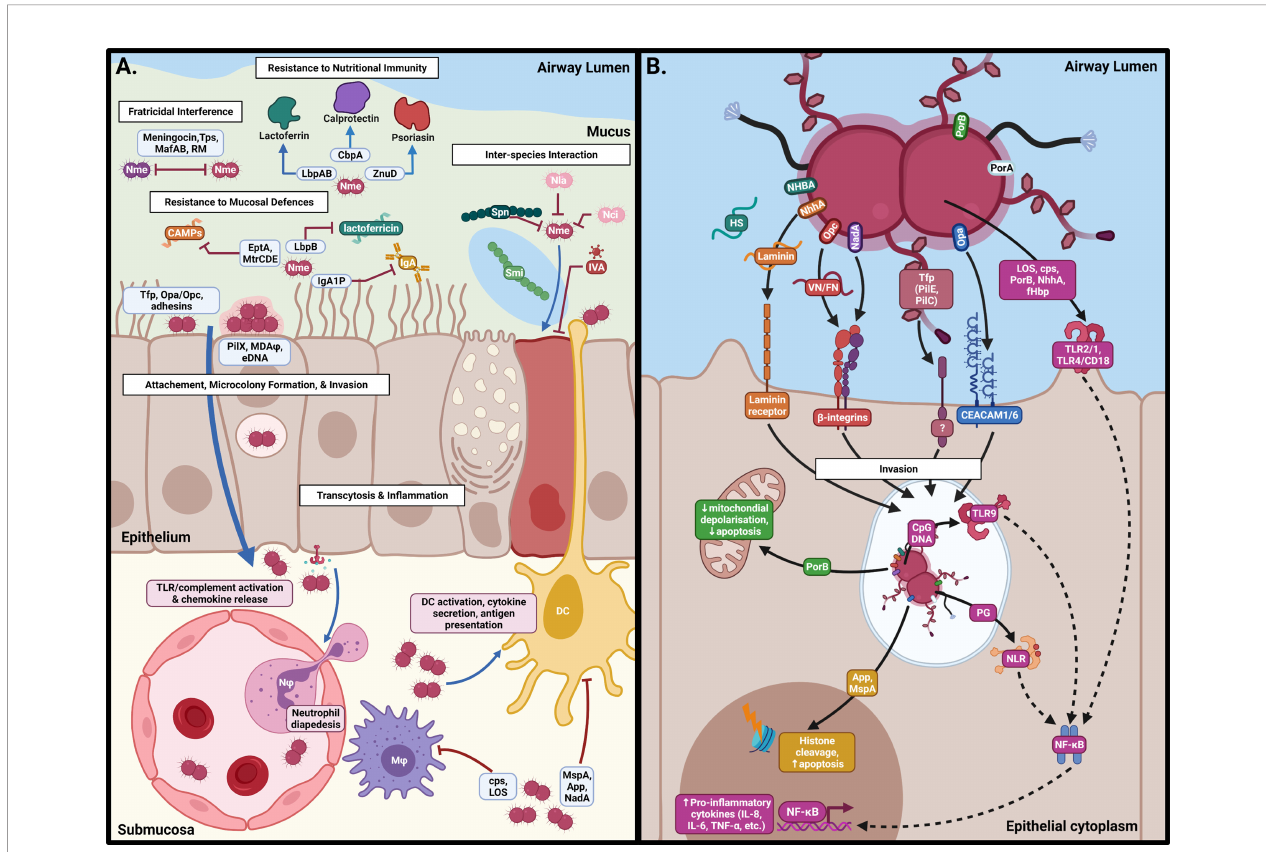
FIGURE 2 | Interactions of N. meningitidis at the nasopharyngeal surface. (A) Following acquisition, Nme must survive against host defences, interactions with other members of the microbiome, and intra-speci fi c competition in order to inhabit the mucus of the nasopharynx. Eventual binding of the epithelial surface results in intimate association and passage into the submucosa by transcytosis. (B) Binding of epithelial cells occurs by interaction of Neisserial surface structures with their cognate receptors, resulting in in fl ammation, cellular restructuring, and transcytosis. This fi gure was created using